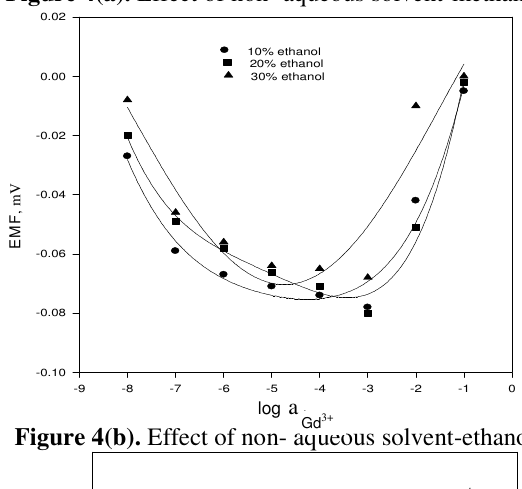
Figure 4(a). Effect of non- aqueous solvent-methanol .